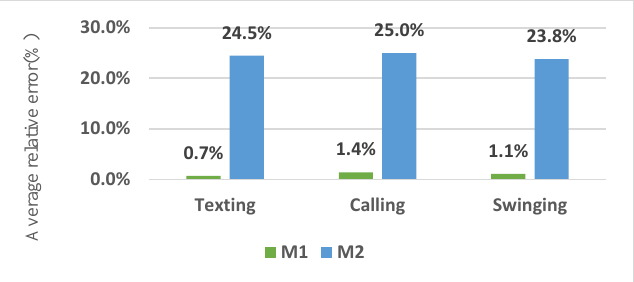
Figure 12. Comparison of the average relative errors of distance estimation in the 3D trajectory.